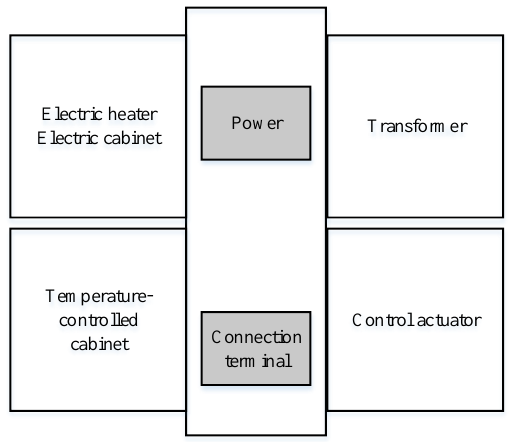
Figure 1. Terminal diagram of VAV BOX controller.